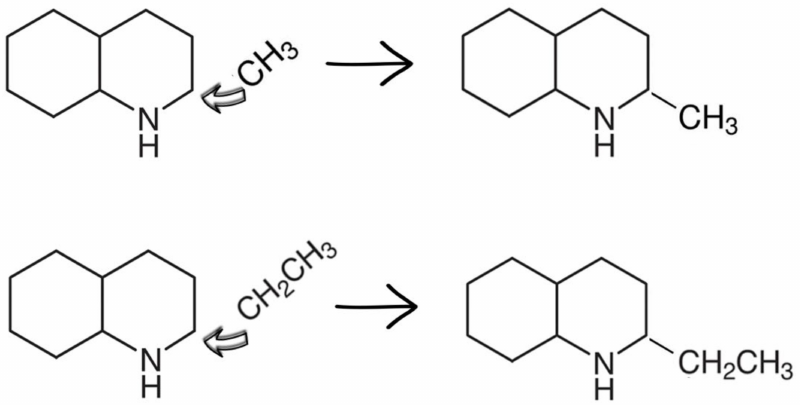
Figure 4. Calculation of enthalpies of formation, ∆ f H o m (liq), of alkyl-substituted decahydroquinolines using the H → CH 3 ( − 37.8 ± 0.8) and H → CH 2 CH 3 ( − 71.6 ± 1.8) increments for piperidine ring (see Figure 3).